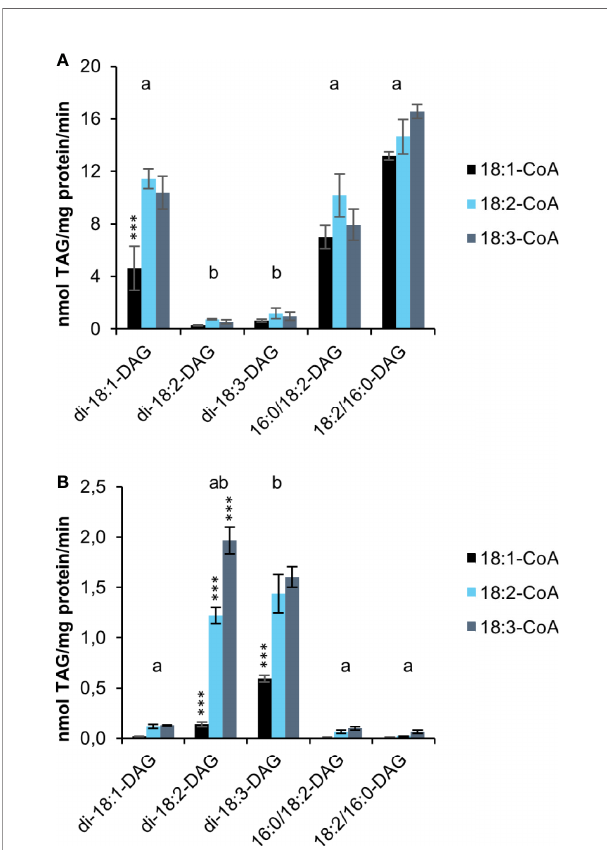
FIGURE 3 | Acyl-CoA and DAG speci fi cities of C. sativa DGAT enzymes in in microsomal preparations from yeast expressing the enzymes, when fed exogenous long-chain DAGs and [ 14 C]acyl-CoA as indicated in the fi gure. Background activity (no DAG added) was subtracted in the fi gure (see Supplementary Table 1 ). (A) DGAT1 and (B) DGAT2. Average value shown ± SD, n = 3 replicates. Stars over individual bars indicate signi fi cant differences compared to the other Acyl-CoA species with the same DAG according to one-way ANOVA followed by Tukey ’ s test performed on the whole dataset. ***p ≤ 0.001. Different letters over DAG species indicate signi fi cant differences between DAG species of all Acyl-CoA combinations at the level of p ≤ 0.001. Complete results of the statistical analysis can be found in Supplementary Tables 2 (DGAT1) and 3 (DGAT2).